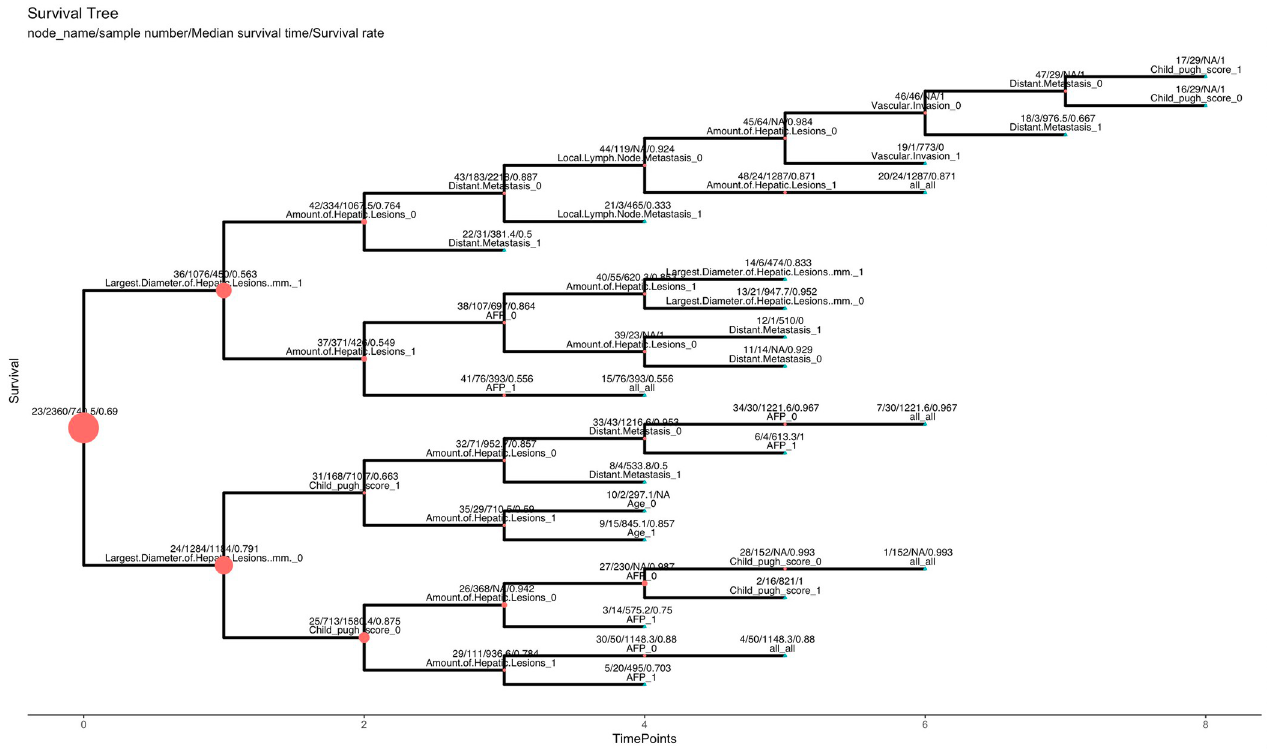
Fig 3. Graph of survival path computed as demonstration. The graph was built using ggtree based on tree-structure data.